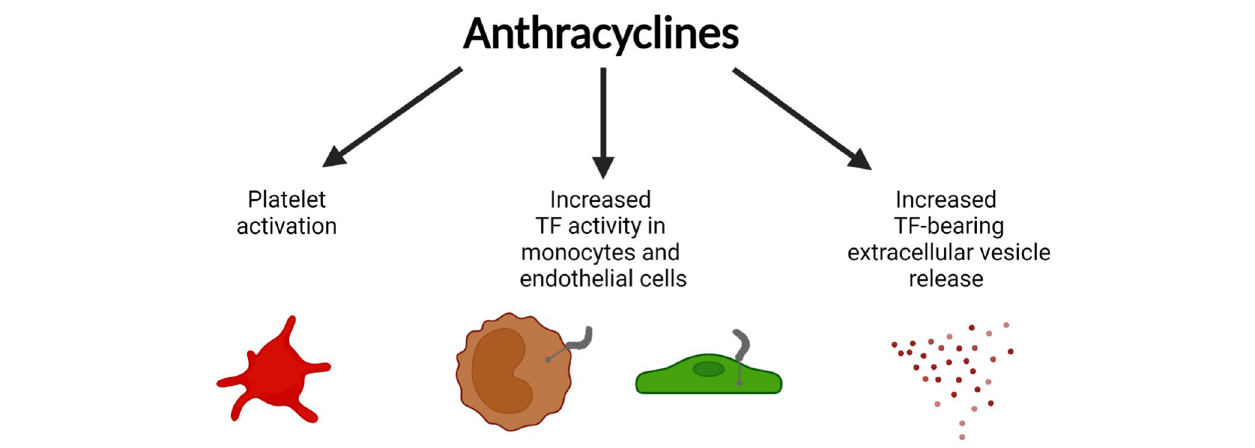
FIGURE 1 | Prothrombotic effects of anthracyclines. Anthracyclines (doxorubicin, daunorubicin) activate vascular cells including platelets, monocytes, and endothelial cells leading to surface phosphatidylserine (PS) exposure, increased activity of pre-existing tissue factor (TF) on monocytes and endothelial cells, and the release of TF-bearing extracellular vesicles (EV). Figure created with